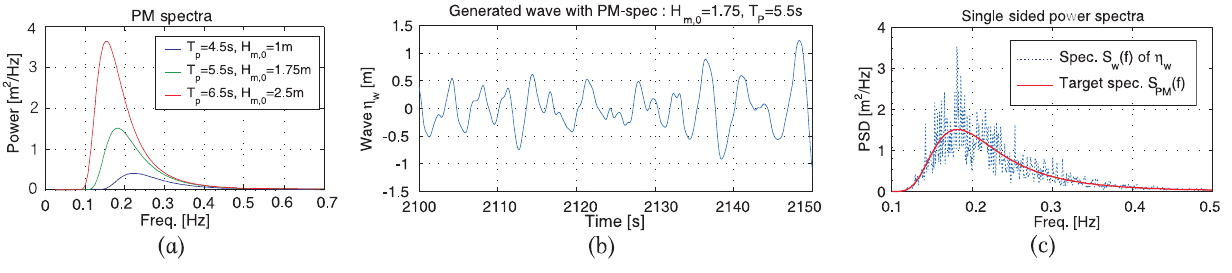
Figure 9. Wave spectra for three sea states and an example of a realization of a